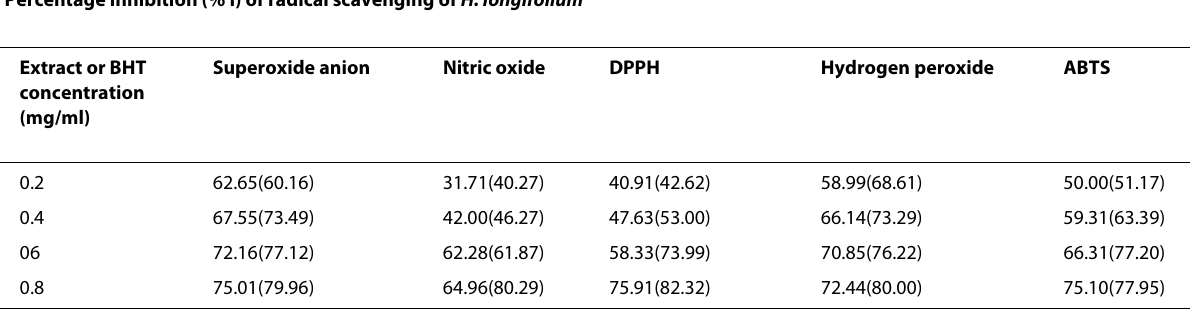
Table 2: Radical scavenging activities of aqueous crude leaf extract of H. longifolium and BHT as standard at different